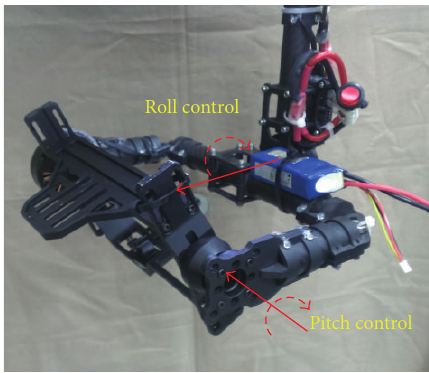
Figure 2: Airborne dual-axis antenna stabilization gimbal.